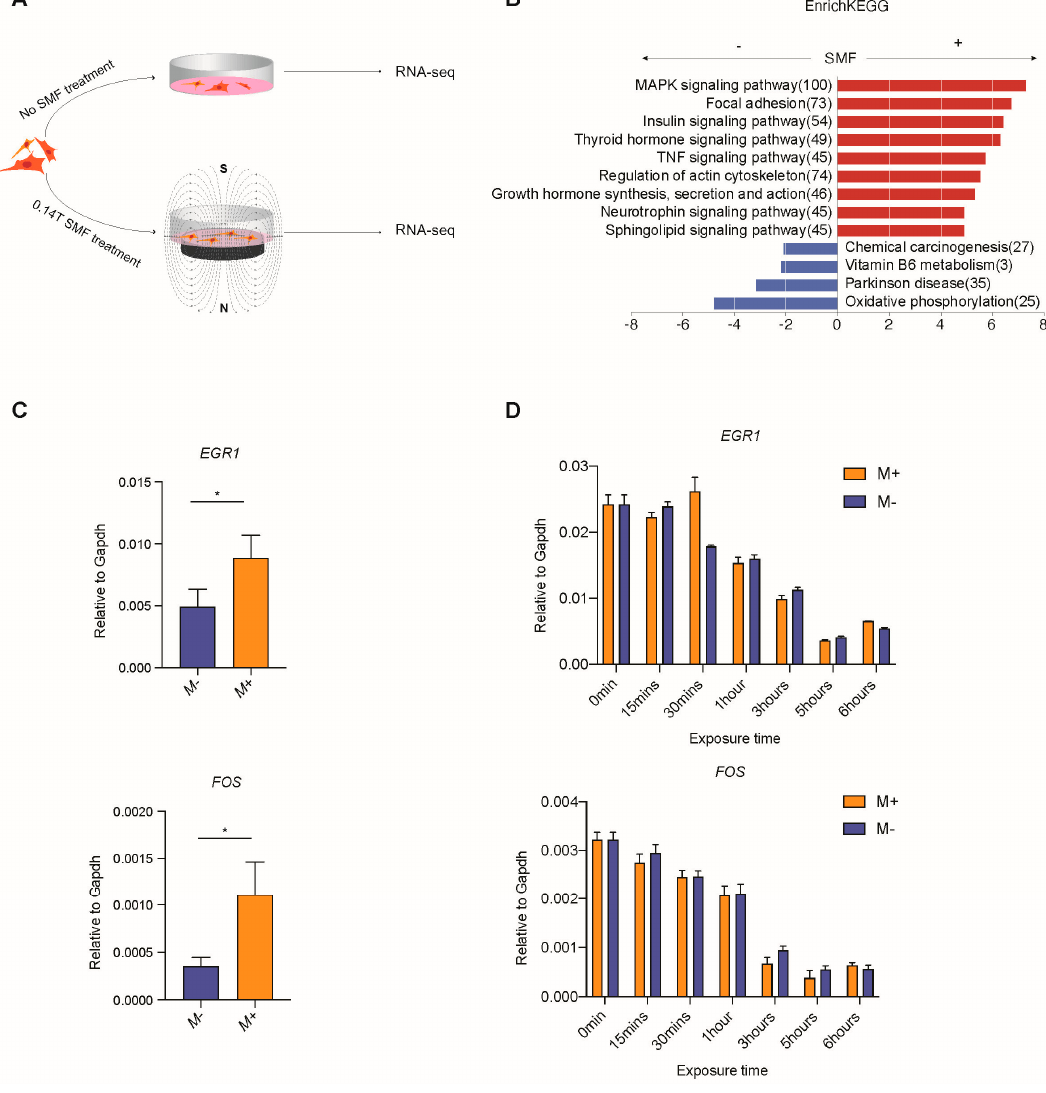
Figure 2. Exposure to SMF upregulates immunoregulatory factor genes and MAPK-signal-pathway-related genes in MSCs. ( A ) Schematic of experimental approach. ( B ) Bar chart of the gene expression differences between M+ and M − cell samples by RNA-seq of various KEGG function terms. ( C ) RT-qPCR analysis for expression of EGR1 and FOS in M+ (magnetic field induction 140 mT) and M − MSCs samples cultured for 72 h. Asterisks indicate statistical significance of the separation between the mean of the medians according to unpaired two-tailed t -test between conditions. ns p > 0.05; * p < 0.05. ( D ) Time-course RT-qPCR analysis for expression of EGR1 and FOS in M+ and M − MSCs samples cultured for 0–6 h. Data are mean ± s.d., N = 3 independent experiments. In addition, a 6-hour time-course q-PCR for FOS and EGR1 illustrated the changes in expression within the first 6 h after MSCs were seeded (Figure 2D). Both genes experi- enced a rapid drop in the first 5 h and then climbed up slightly at the 6th hour and re- mained consistent over 72 h. We did not observe a significant difference in FOS between M+ and M − , which means that SMFs do not play a crucial role in regulating FOS at the